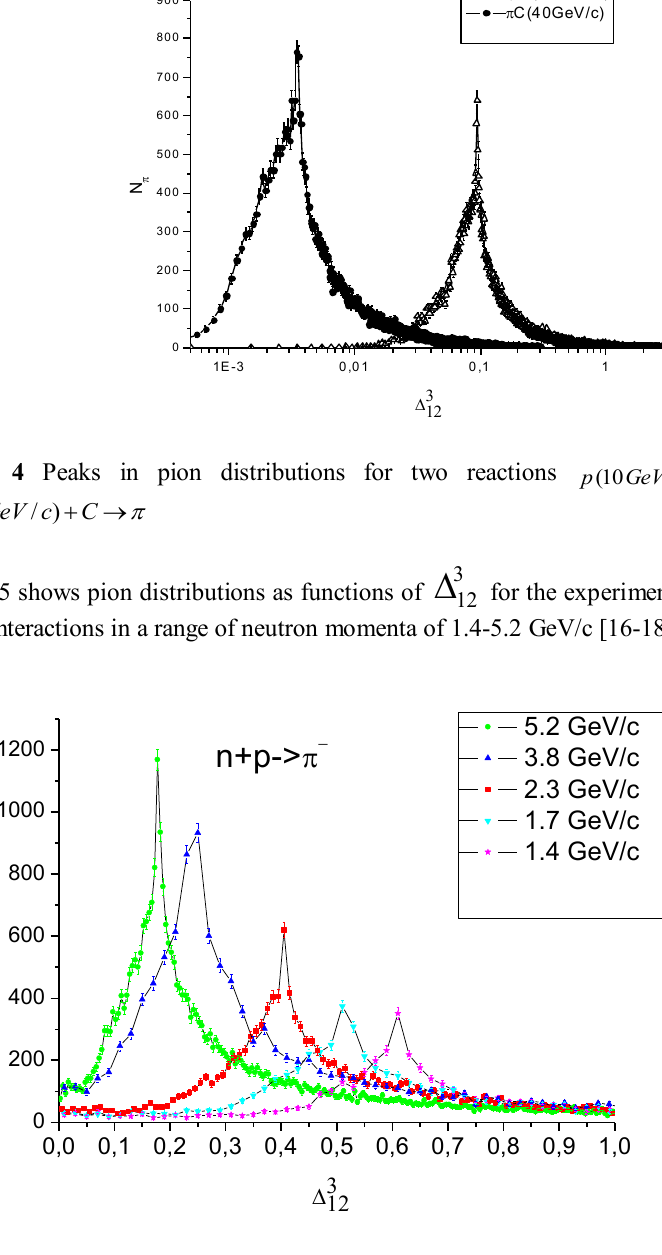
Figure 5. Pion production in pn + reaction for different neutron